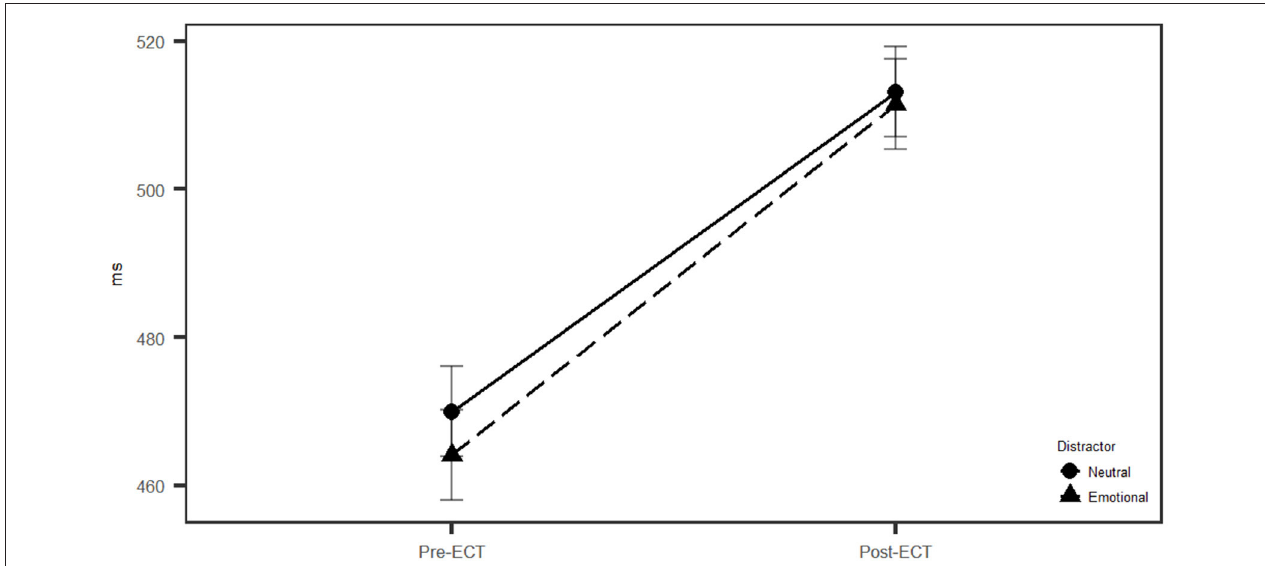
FIGURE 2 | Reaction times in the context of threat related and neutral distractor pre- and post-electroconvulsive therapy (post-ECT). Pre-electroconvulsive therapy (ECT) subjects had faster reaction time, and emotional distractor speeded up their reaction times (RTs) compared to neutral distractor ( p = 0.006).